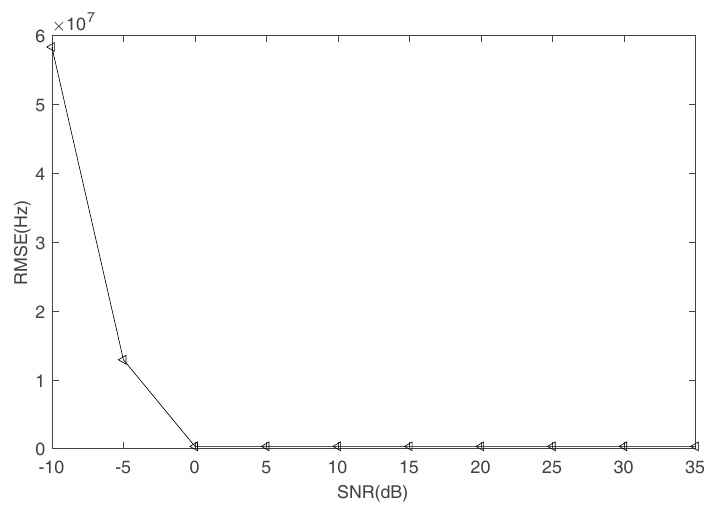
Figure 13. The RMSE of frequency estimation.